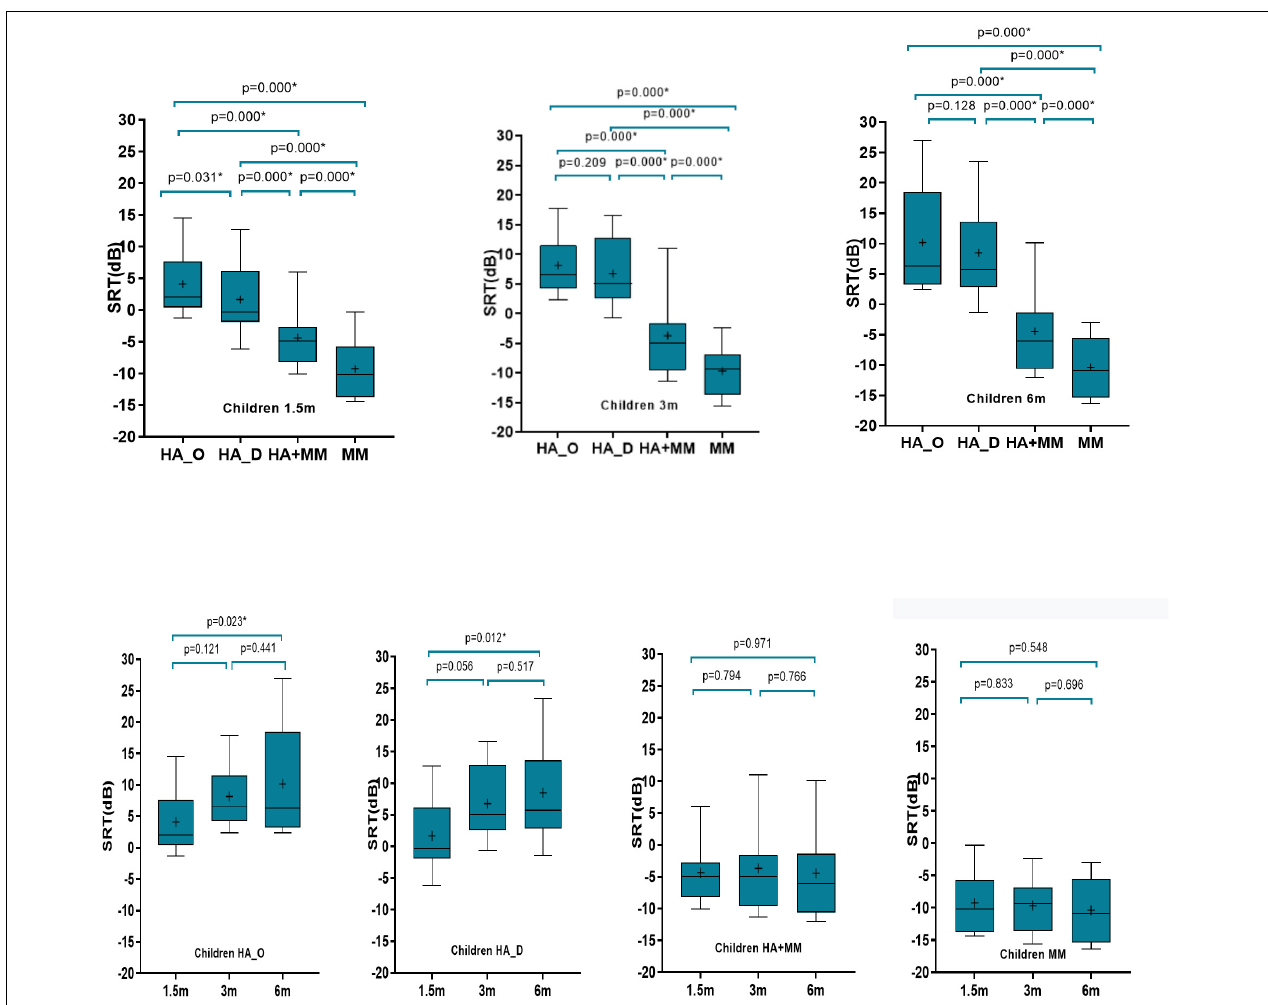
FIGURE 4 | Comparison of speech in noise recognition threshold (measured in SNR) of pediatric subjects at different test distances and different test device settings. Boundaries of the boxes indicate the 25th and 75th percentile. Whiskers indicate the 10th and 90th percentiles. Solid lines denote the median. Plus (+) denotes the